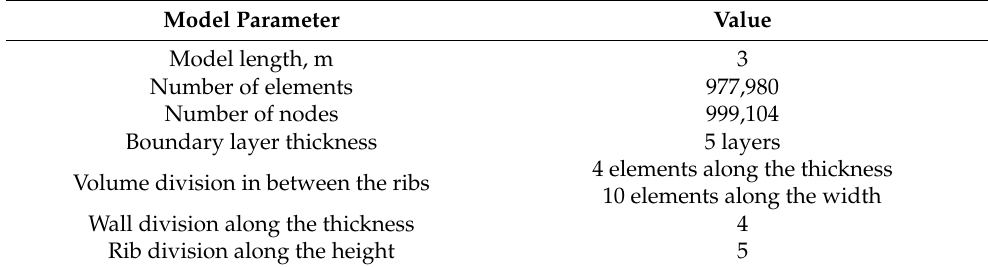
Table 2. Parameters of the numerical meshes used for the calculations of the heat transfer coefficient. Model Parameter Value Model length, m 3 Number of